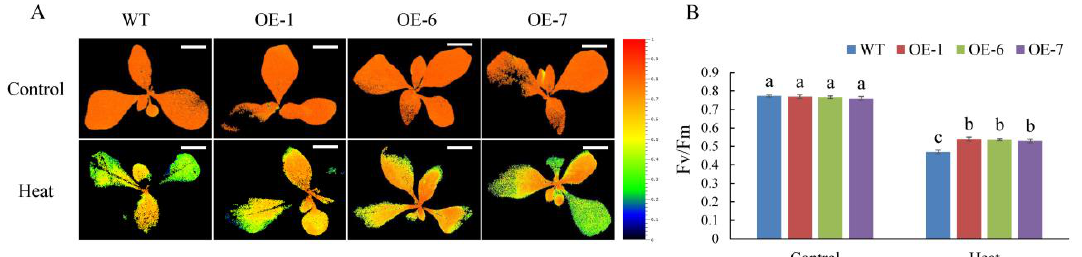
Figure 8. Overexpression of MdPRP6 enhanced the Fv/Fm after 6 h under control and heat conditions. ( A ) Fv/Fm image obtained from chlorophyll fluorescence imaging and ( B ) Fv/Fm. Scale bar = 3 cm. Data are means of three replicates with SD. Different letters indicate significant differences between WT and MdPRP6 transgenic plants with or without heat stress (48 °C, 6 h), according to one-way ANOVA and Tukey’s multiple range tests ( p < 0.05).